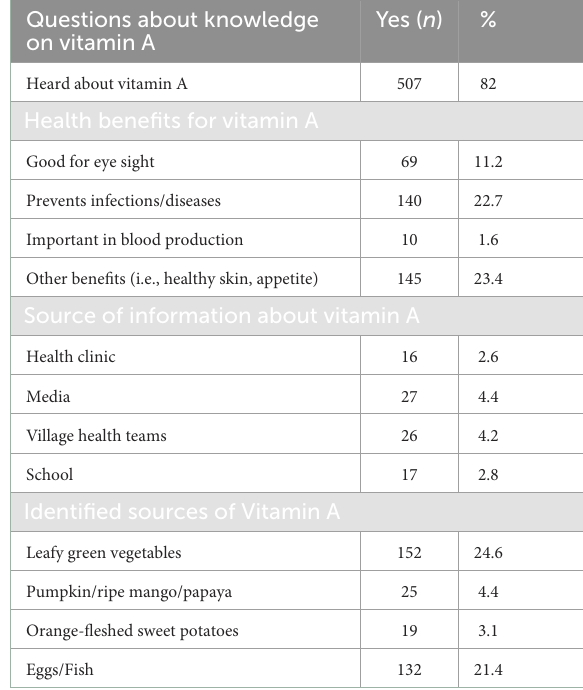
TABLE 2 Women’s knowledge about vitamin A.